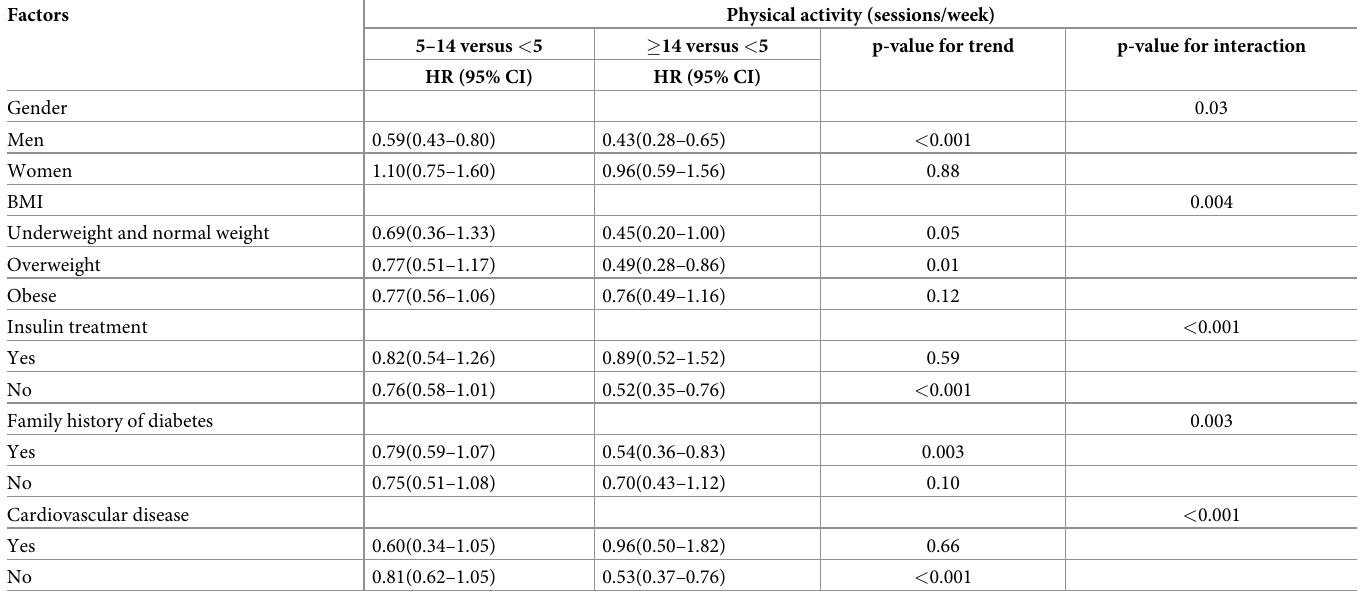
Table 3. Fully adjusted models for associations between physical activity and retinal photocoagulation stratified by gender, BMI, insulin used, family history of dia- betes, hypertension and cardiovascular disease